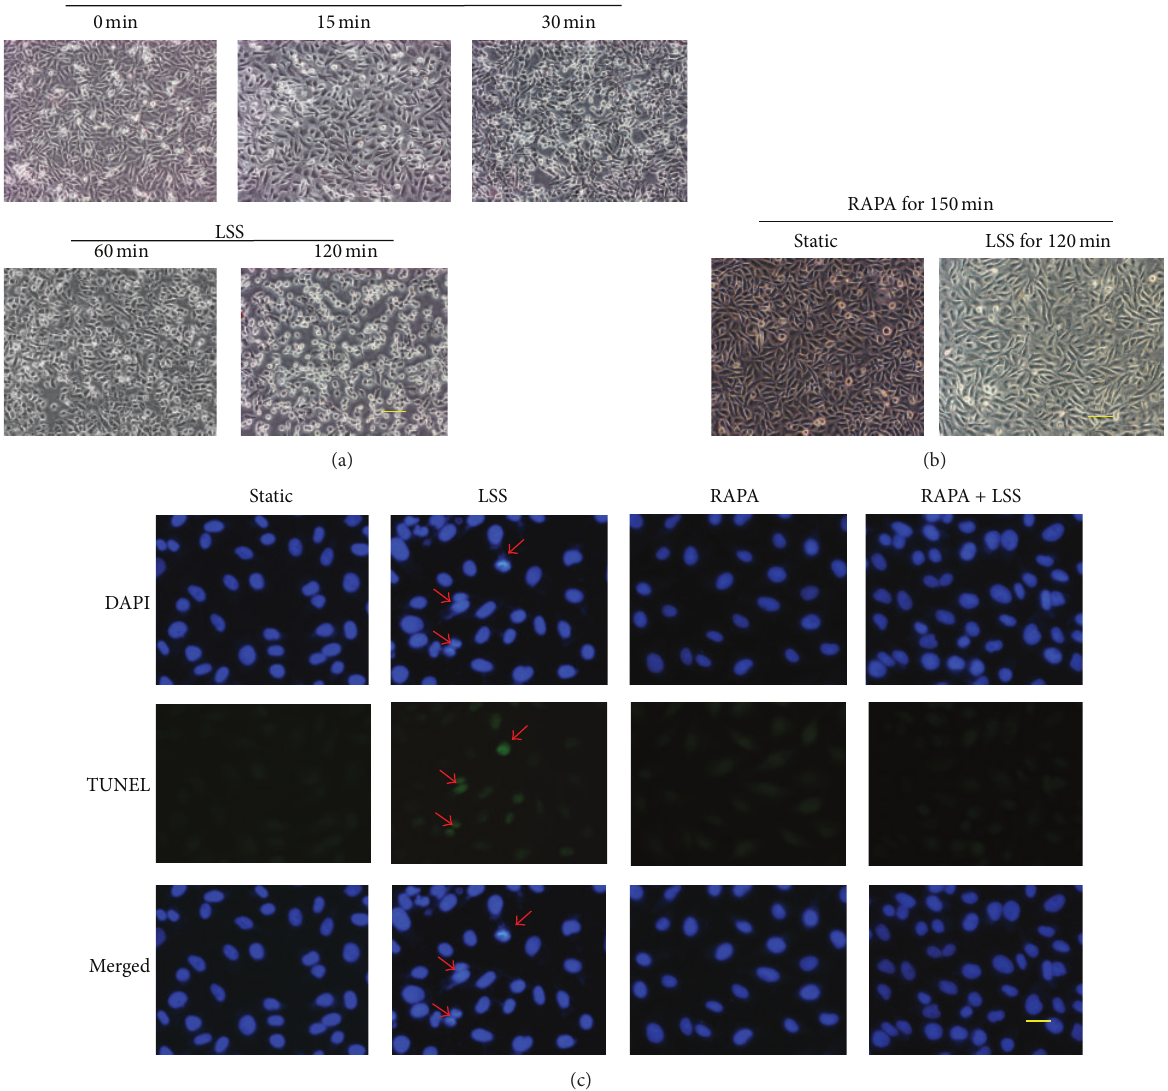
Figure 1: LSS induced EC apoptosis was attenuated by rapamycin. LSS at 2dyne/cm 2 caused EC viability reduction and apoptosis which was attenuated by rapamycin (RAPA) at the concentration of 100ng/mL (a) HUVECs shape change and detachment after being subjected to LSS for the various time points. (b) Pretreated HUVECs with RAPA for 30min and continuously delivered RAPA during flow study for 120min abrogated LSS effect on cell shape change and detachment. (c) DAPI and TUNEL staining were used to label apoptotic RAECs (arrows show apoptotic cells). Adding RAPA appeased LSS induced apoptosis and RAPA alone had no influence on apoptosis. Scale bars: 100 𝜇 m ((a)-(b)), 25 𝜇 m